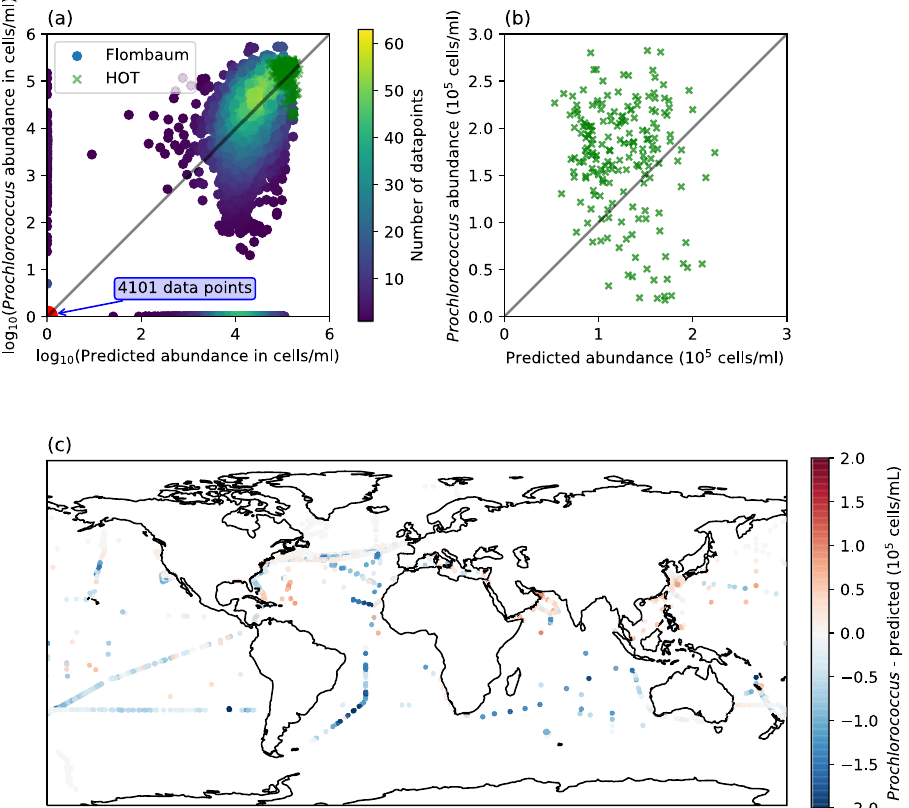
Fig. 2 | Comparison of model predictions and observations. a A log-log plot of the Prochlorococcus abundance predicted by the Flombaum model, vs the mea- sured abundance, including data points from both the original Flombaum dataset andtheHOTdataset. b Alinearscaleplotofthepredictedvsactual Prochlorococcus